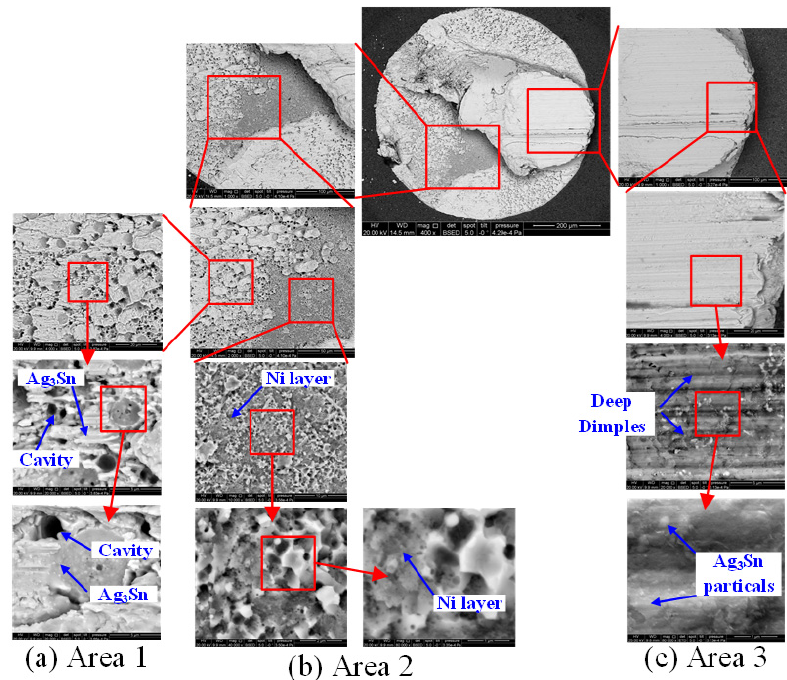
Figure 6. Typical ball SEM image and its partial areas.